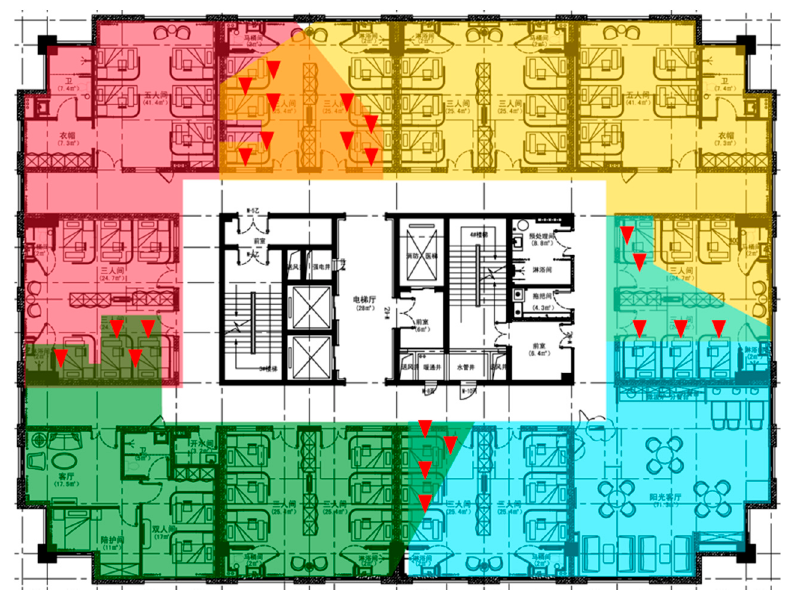
Figure 7. Area partition result. In total, 4 zones are formed after clustering, which are depicted in red, yellow, green and blue. In total, 22 RPs denoted by red triangles are located in the overlap regions.